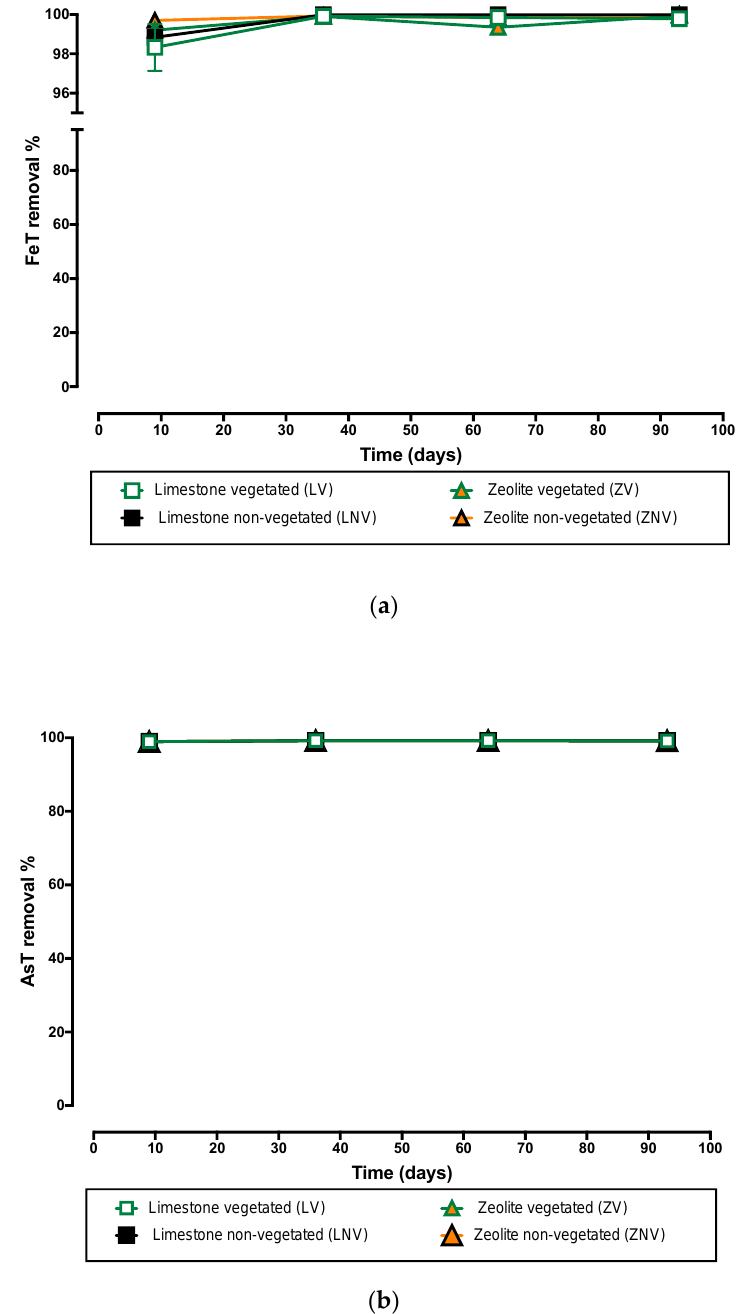
Figure 3. Iron ( a ) and arsenic ( b ) removal in the zeolite and limestone cells (vegetated and non-vegetated). Data corresponds to average values, and error bars indicate minimum and maximum values for each cell type. When measurements were reported below the limit of detection, half of the corresponding value was considered as the actual